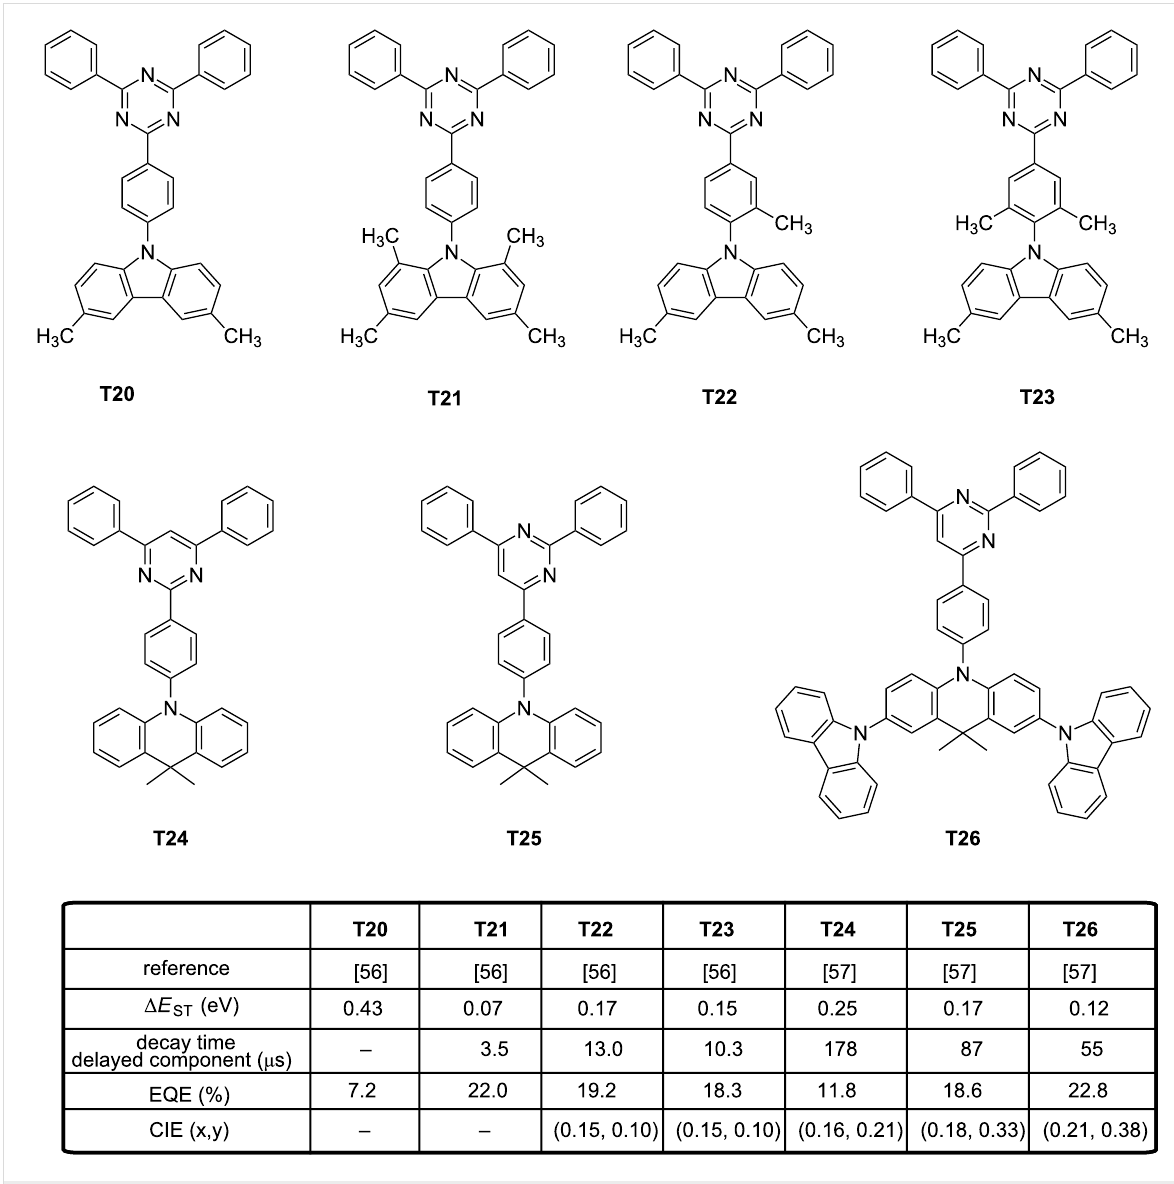
opposite, prompt and delayed fluorescence components